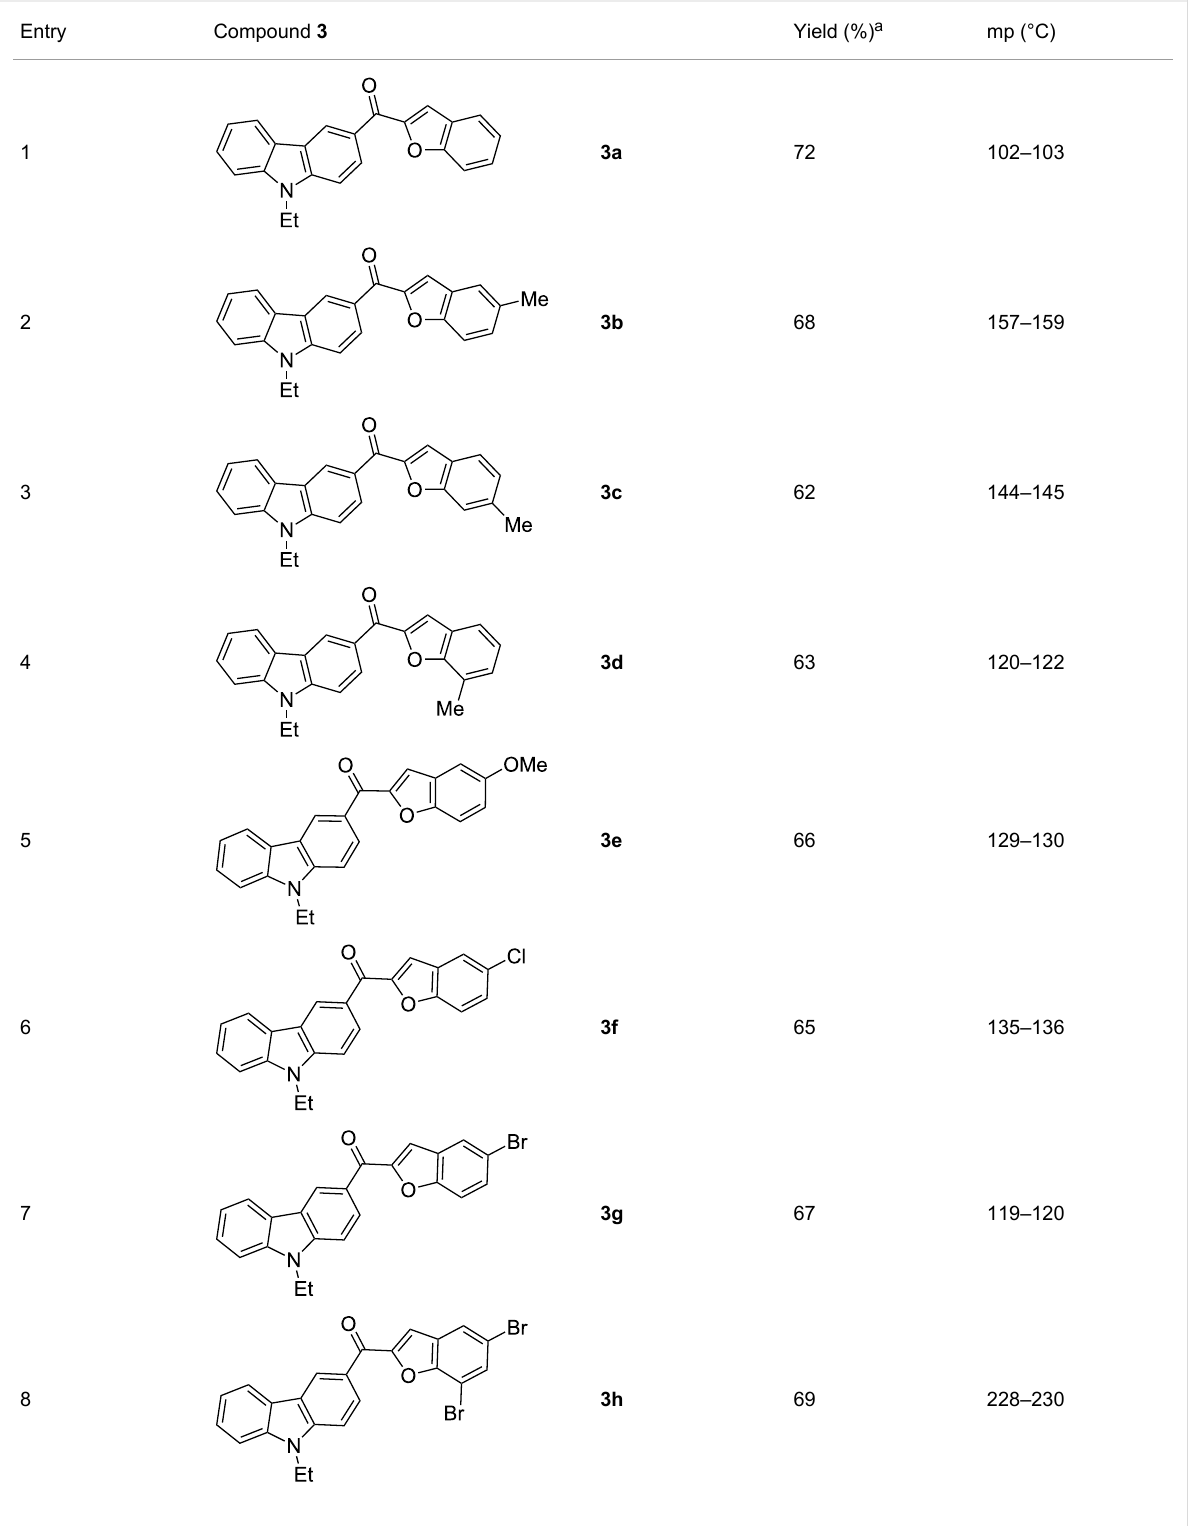
Table 1: Synthesis of 3-(2-benzofuroyl)carbazole derivatives ( 3a – k